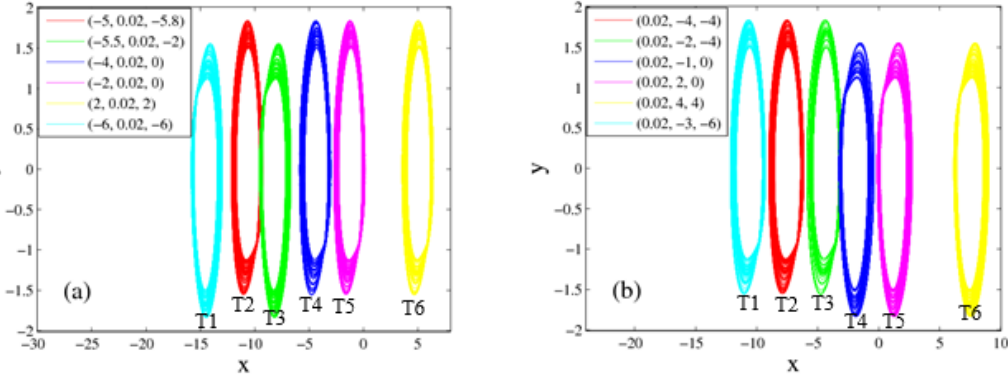
Figure 11. Coexistence attractor with ( a ) different x 0 and z 0 ; ( b ) different y 0 and z 0 .